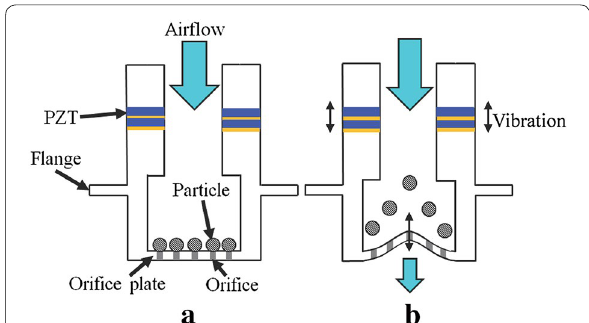
Fig. 1 Basic control mechanism of control valve a non-driving state, b driving